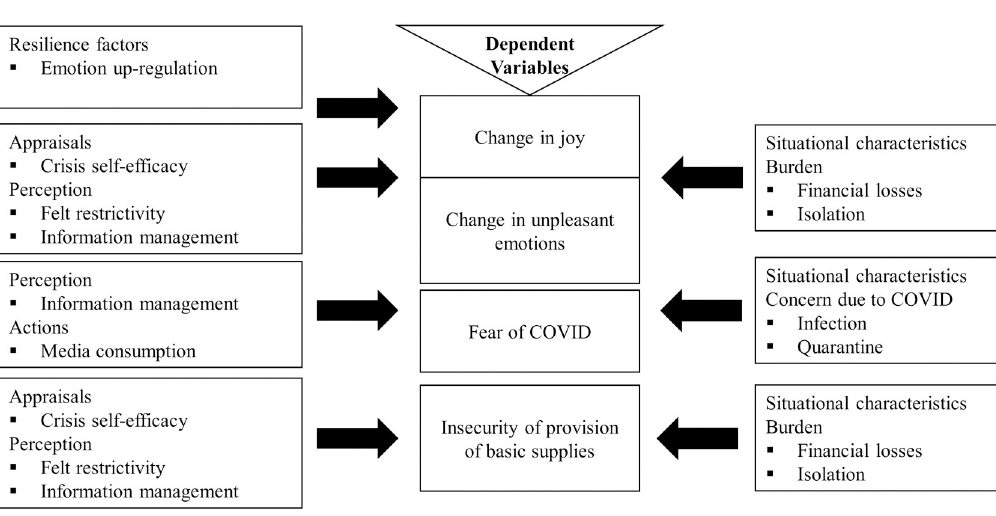
Fig 1. Overview of predictors included in the regression